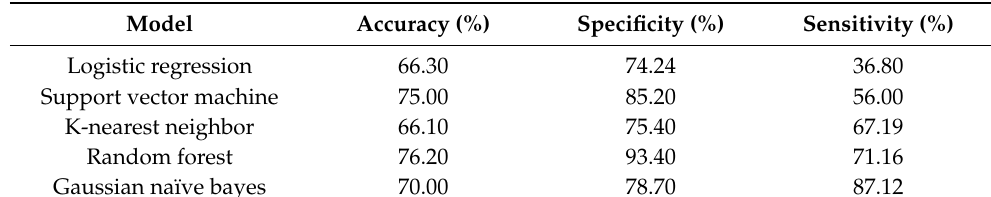
Table 2. Performance evaluation result of classification models with full features.